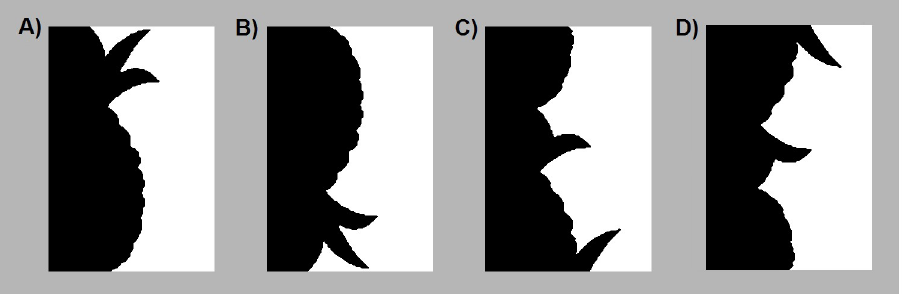
Fig 1. A sample bipartite stimulus in 4 configurations. In this figure, the critical side is presented in black on the left of the central border. When these stimuli are used, black/white contrast and left/right location of the critical side is balanced; they are presented on a medium gray backdrop. A) Upright Intact , B) Inverted Intact , C) Upright